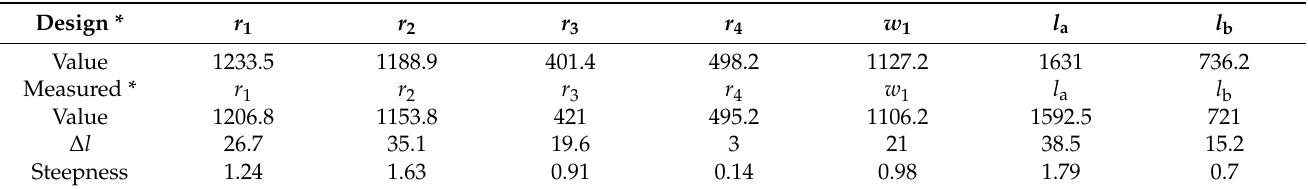
Table 2. Designed and measured physical dimensions for the SU-8 fabricated filter (unit: µ